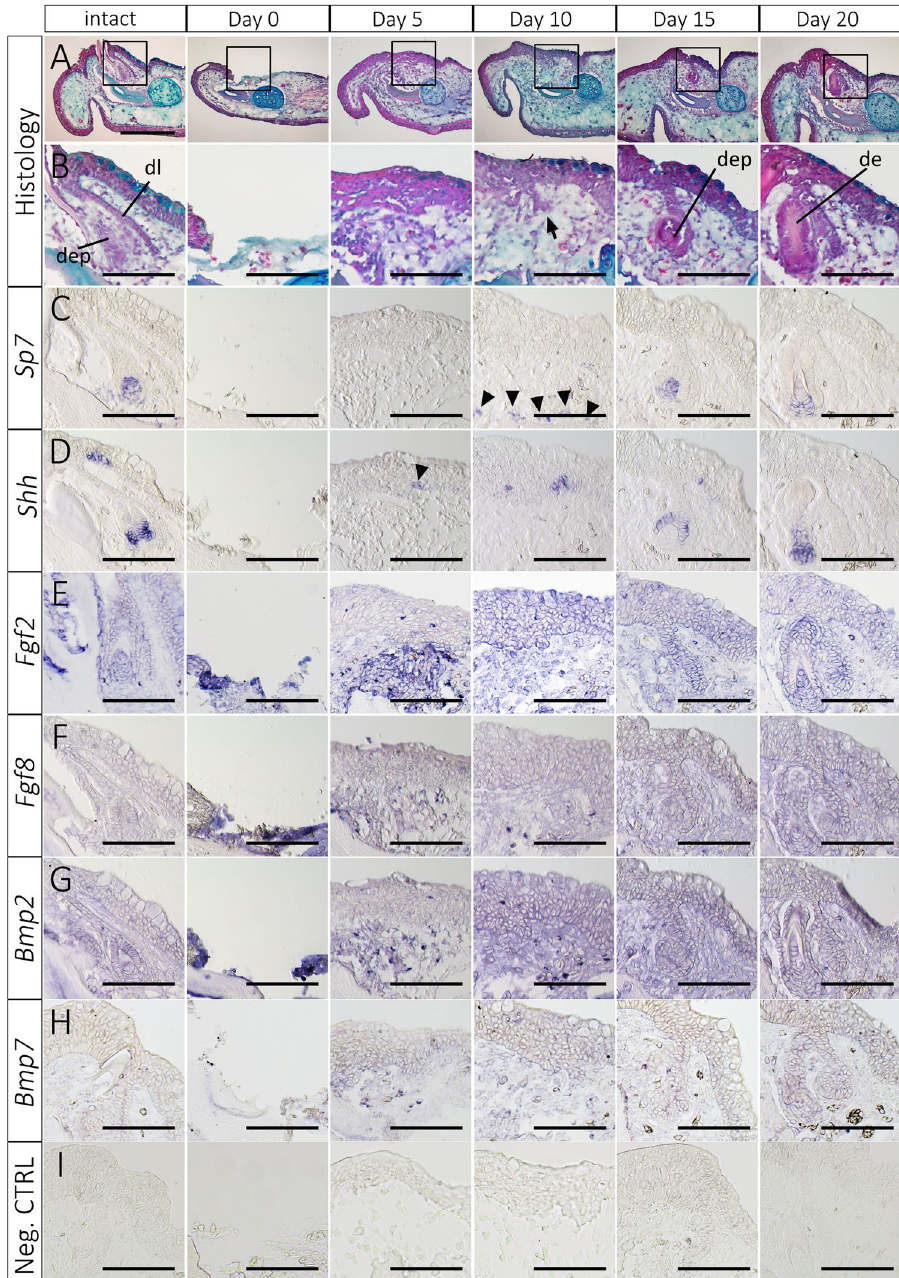
Figure 4. Gene expression patterns in the regenerating tooth. ( A,B ) Histological observations in the regenerating tooth. The images in rows B-H are higher magnification views of the boxed regions in row A. Arrow in B indicates the initiation of the invagination of the oral epithelium. dl = dental lamina. dep = dental epithelium. de = dentine. ( C ) Sp7 expression. ( D ) Shh expression. ( E ) Fgf2 expression. ( F ) Fgf8 expression. ( G ) Bmp2 expression. ( H ) Bmp7 expression. ( I ) Negative control. RNA probes of green fluorescent protein ( gfp ) were used. Scale bar in A is 500, and scale bars in A–I are 200 μ m. Data are representative of 5 independent